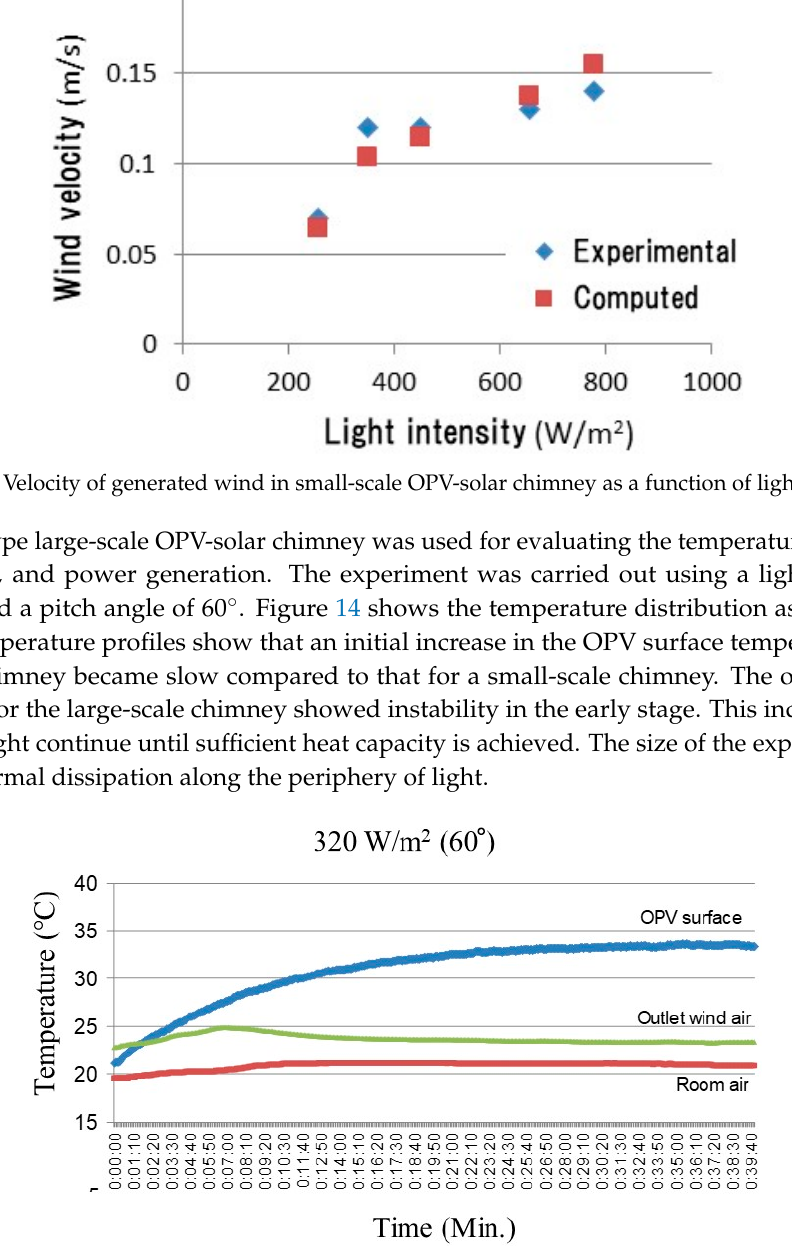
Figure 15. Generated wind velocity in large-scale OPV-solar chimney as a function of time. Figure 16 shows the power generated by the OPV device at a light intensity of 320 W/m 2 . In general, the power generated decreases as the temperature increase in solid-silicon photovoltaics. In contrast, the OPV device generated a constant power even when the temperature of the sheet increased. These results demonstrate the thermal stability of the OPV device in terms of power generation.